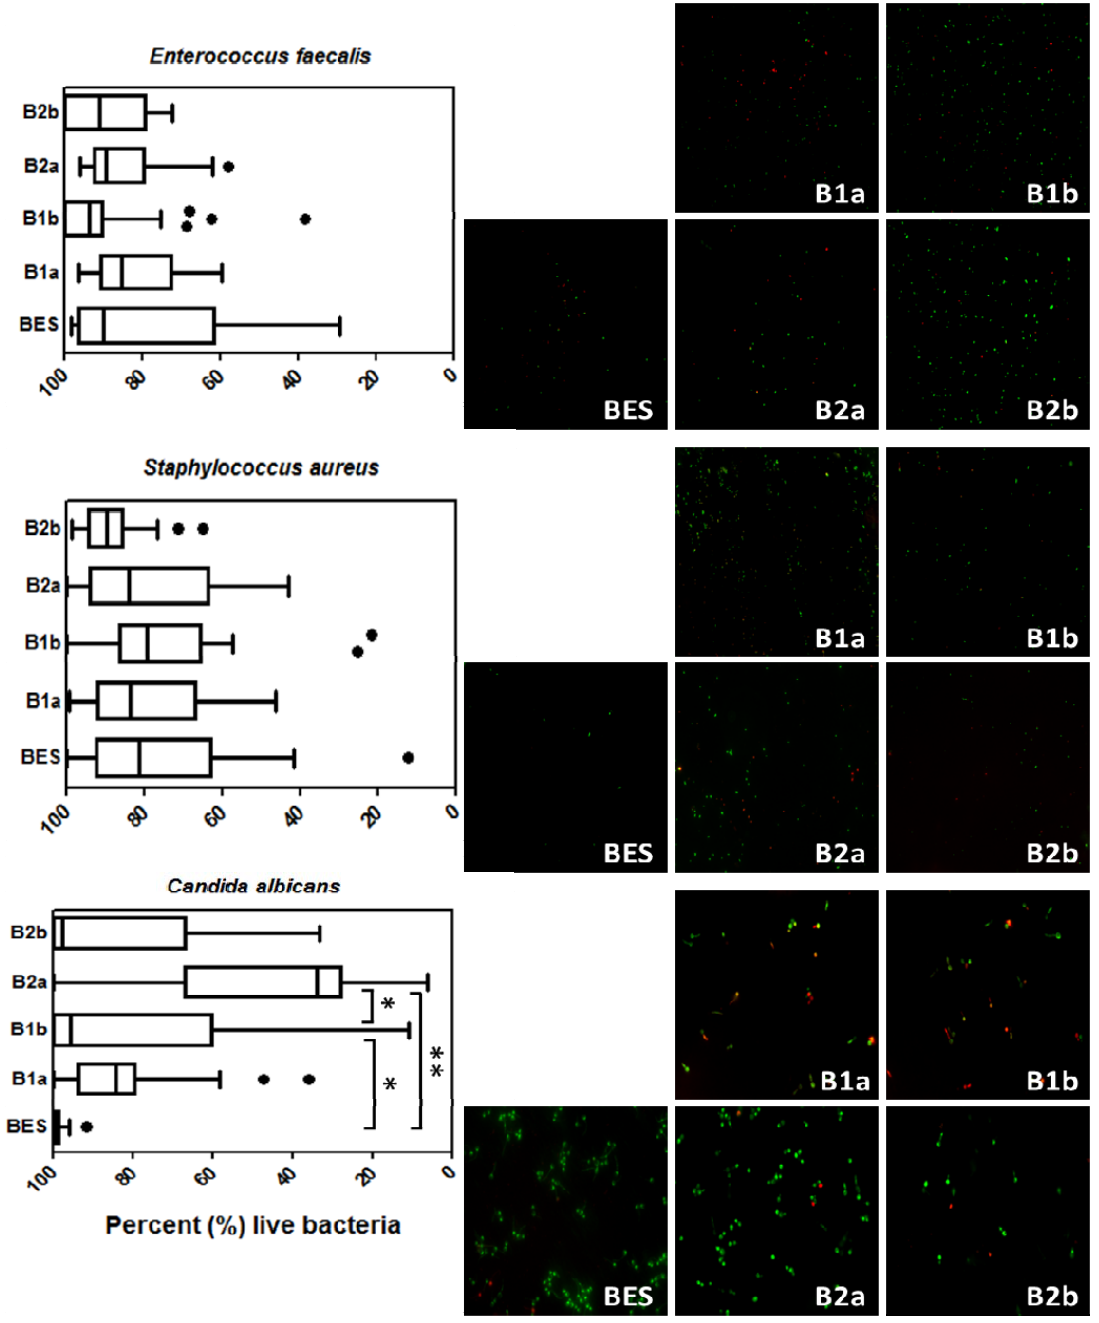
Figure 3. Boxplots exhibiting the viability of Enterococcus faecalis , Staphylococcus aureus and Candida albicans on the different implant material surfaces and the control after an exposure time of 2 h. The medians, whiskers, and Tukey outliers are displayed. The images on the right represent the fluorescence microscopic visualization of the adherent bacteria after the adoption of the live/dead staining. BES: Bovine enamel slabs (control); B1a: 3 mol% yttria-stabilized tetragonal zirconia polycrystal surface; B2a: B1a with zirconium oxide (ZrO ) coating; B1b: B1a with zirconia-based composite coating; 2 ) coatings; * p ≤ 0.05, B2b: B1a with zirconia-based composite and zirconium oxide (ZrO 2 ** p ≤